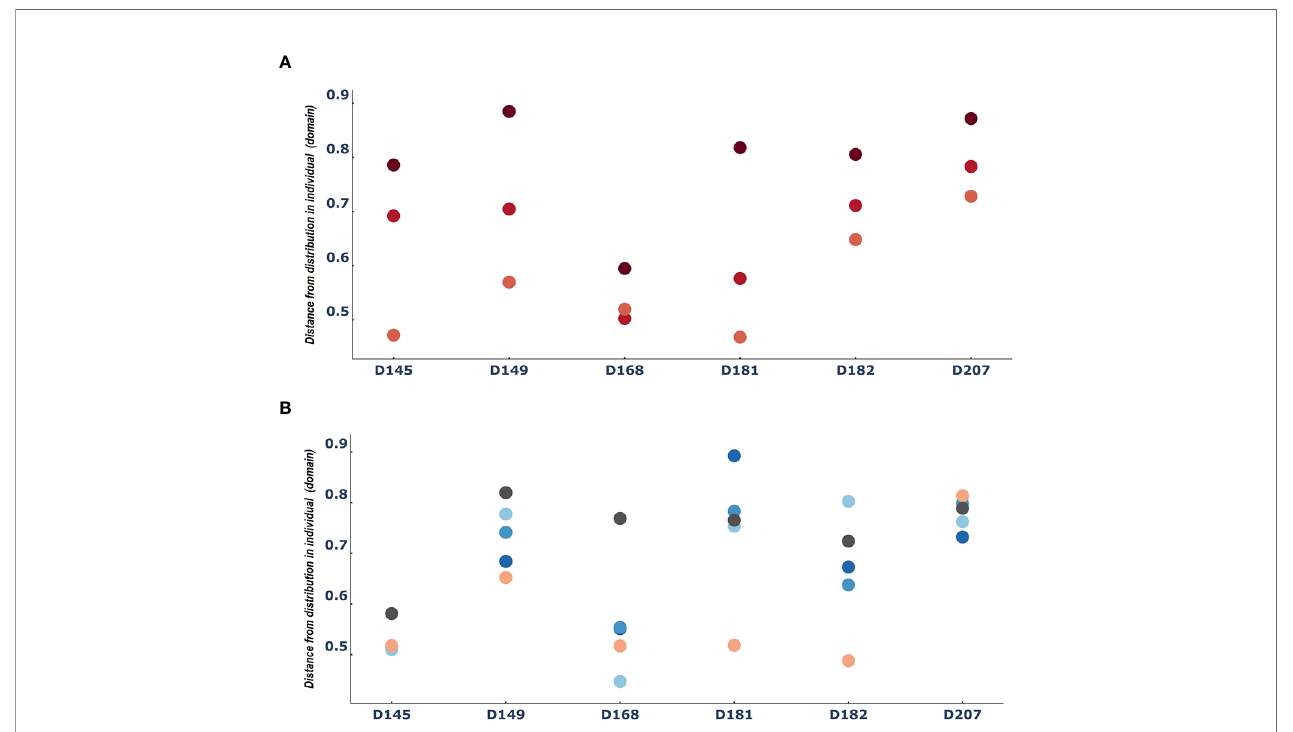
FIGURE 4 | The spleen is reliably more like the entire repertoire than the blood: Median difference between tissue sample entities and the entire domain [i.e. the distribution of clones in a person) (A) for PBL(blood), spleen and BM (bone marrow) and (B) for the rest of the tissues]. Dots are colored by tissue type as in Figure 3 .